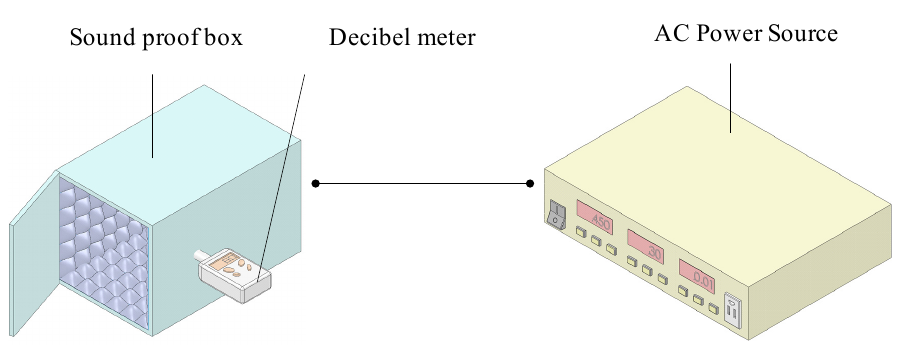
Figure 2. Noise experiment.